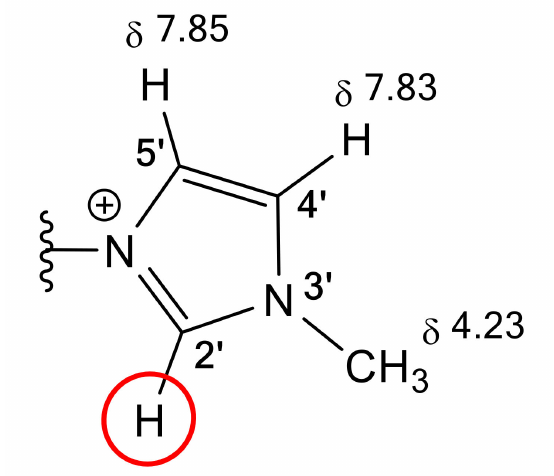
Figure 1. Structure and proton chemical shifts in 1 H NMR spectra of N -methylimidazole moiety of QAS 6